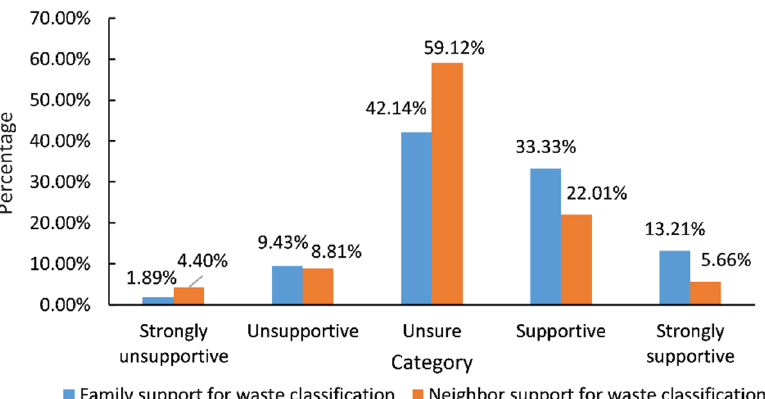
Figure 2. Support of family and neighbors for waste classification.